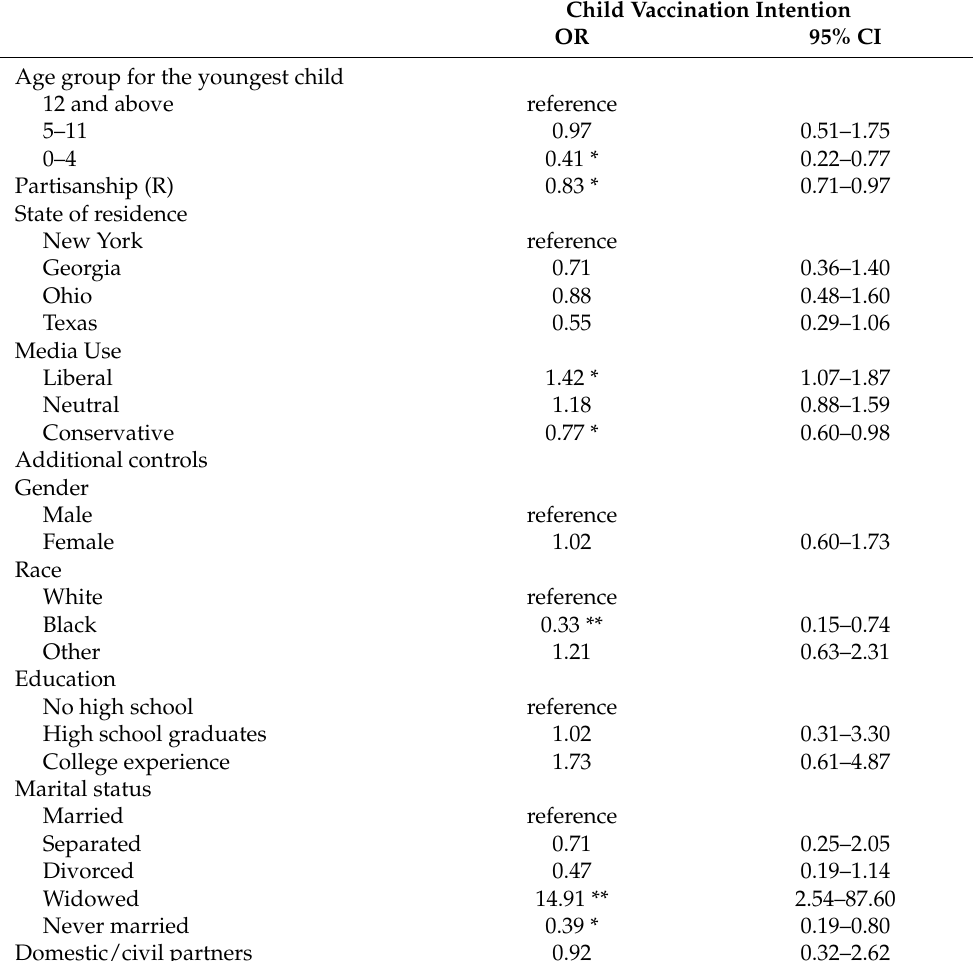
Table 3. Results for the multiple logistic regression